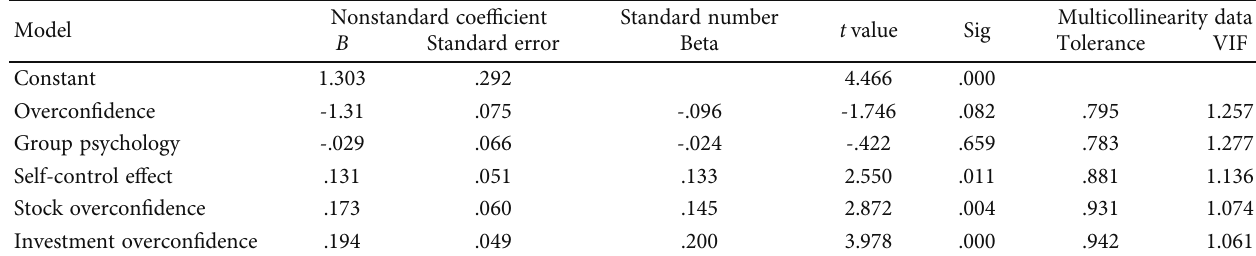
Table 5: Investor sentiment and over trading regression model indicators.